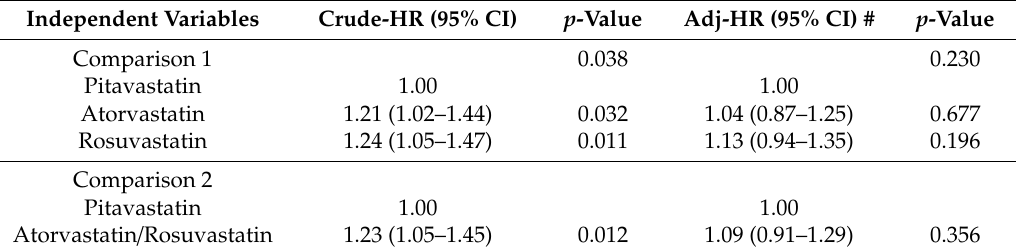
Table 3. HR of three statin groups in NODM.